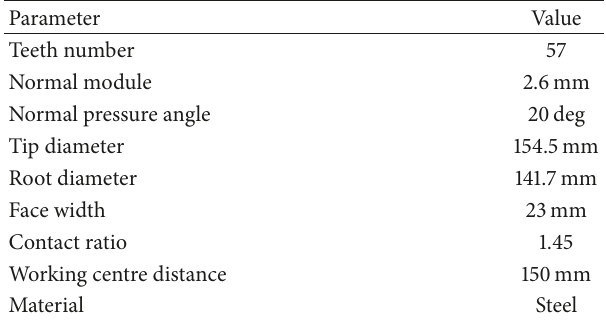
Table 1: Main properties of the